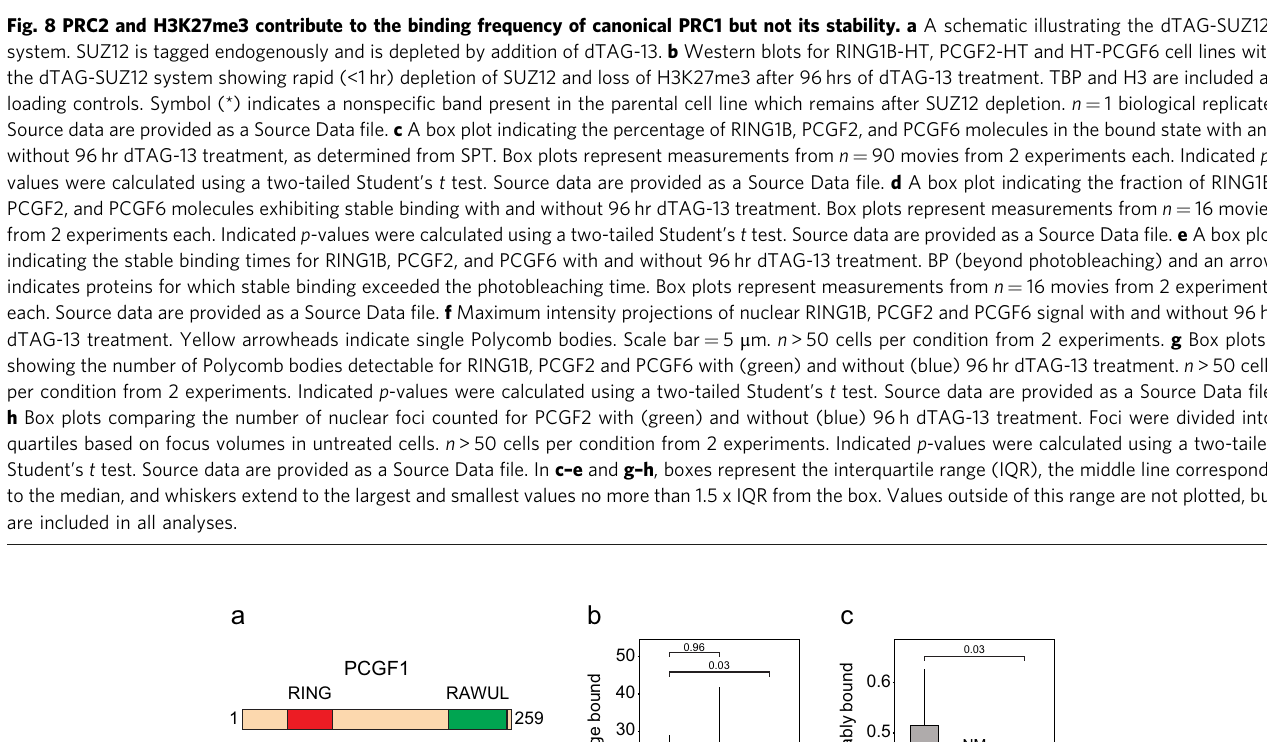
Fig. 9 The C-terminal RAWUL domain of PCGF1 is required for stable chromatin binding. a A schematic illustrating the PCGF1 constructs used for exogenous expression. The RING (aa 47 – 86, red) and RAWUL domains (aa 190 – 253, green) are indicated. b A box plot indicating the percentage of each PCGF1 fusion molecule (FL full length) in the bound state. Box plots represent measurements from n = 90 movies from 3 experiments each. Indicated p -values were calculated using a two-tailed Student ’ s t test. Source data are provided as a Source Data fi le. c . A box plot indicating the fraction each PCGF1 fusion molecule exhibiting stable binding. Stable binding of PCGF1 1 – 129 was not measurable (NM). Box plots represent measurements from n = 16 movies from 2 experiments each. The indicated p -value was calculated using a two-tailed Student ’ s t test. Source data are provided as a Source Data fi le. In b – c , boxes represent the interquartile range (IQR), the middle line corresponds to the median, and whiskers extend to the largest and smallest values no more than 1.5 x IQR from the box. Values outside of this range are not plotted, but are included in all